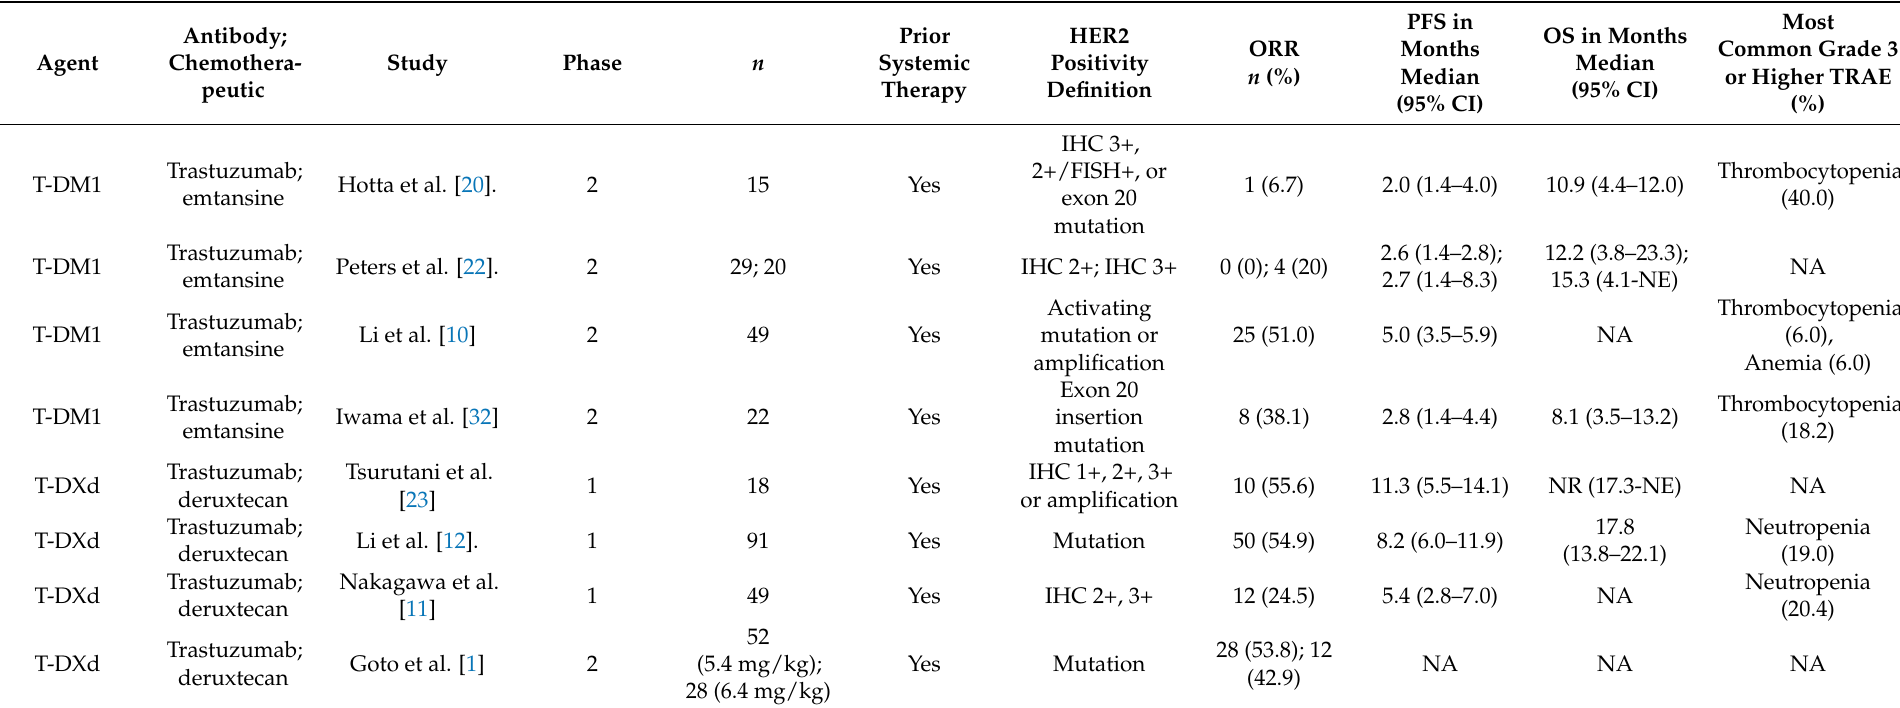
Table 1. Clinical trials evaluating antibody–drug conjugates in patients with NSCLC harboring HER2 aberrations. NSCLC, non-small cell lung cancer; HER2, human epidermal growth factor receptor 2; DAR, drug-to-antibody ratio; ORR, objective response rate; PFS, progression-free survival; CI, confidence intervals; OS, overall survival; TRAE, treatment-related adverse event; IHC, immunohistochemistry; FISH, fluorescence in situ hybridization; NE, not evaluable; NA, not available; NR, not